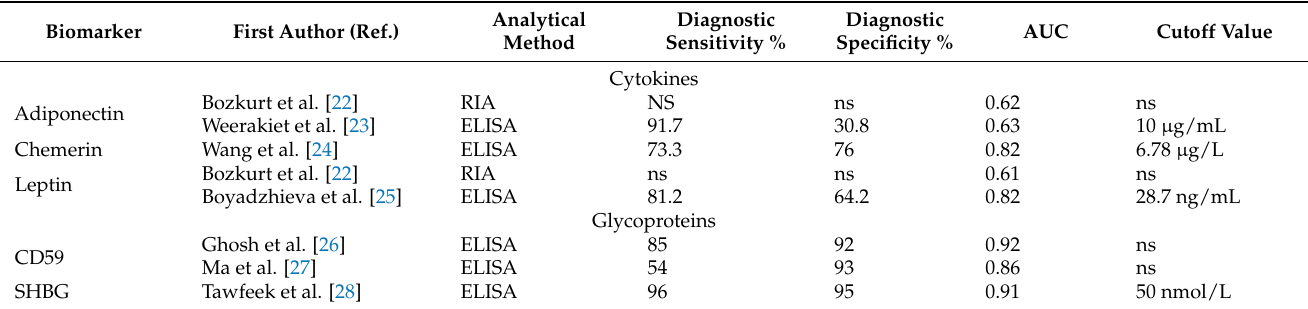
Table 2. Summary of test performance at the time of gestational diabetes (GDM) diagnosis *.